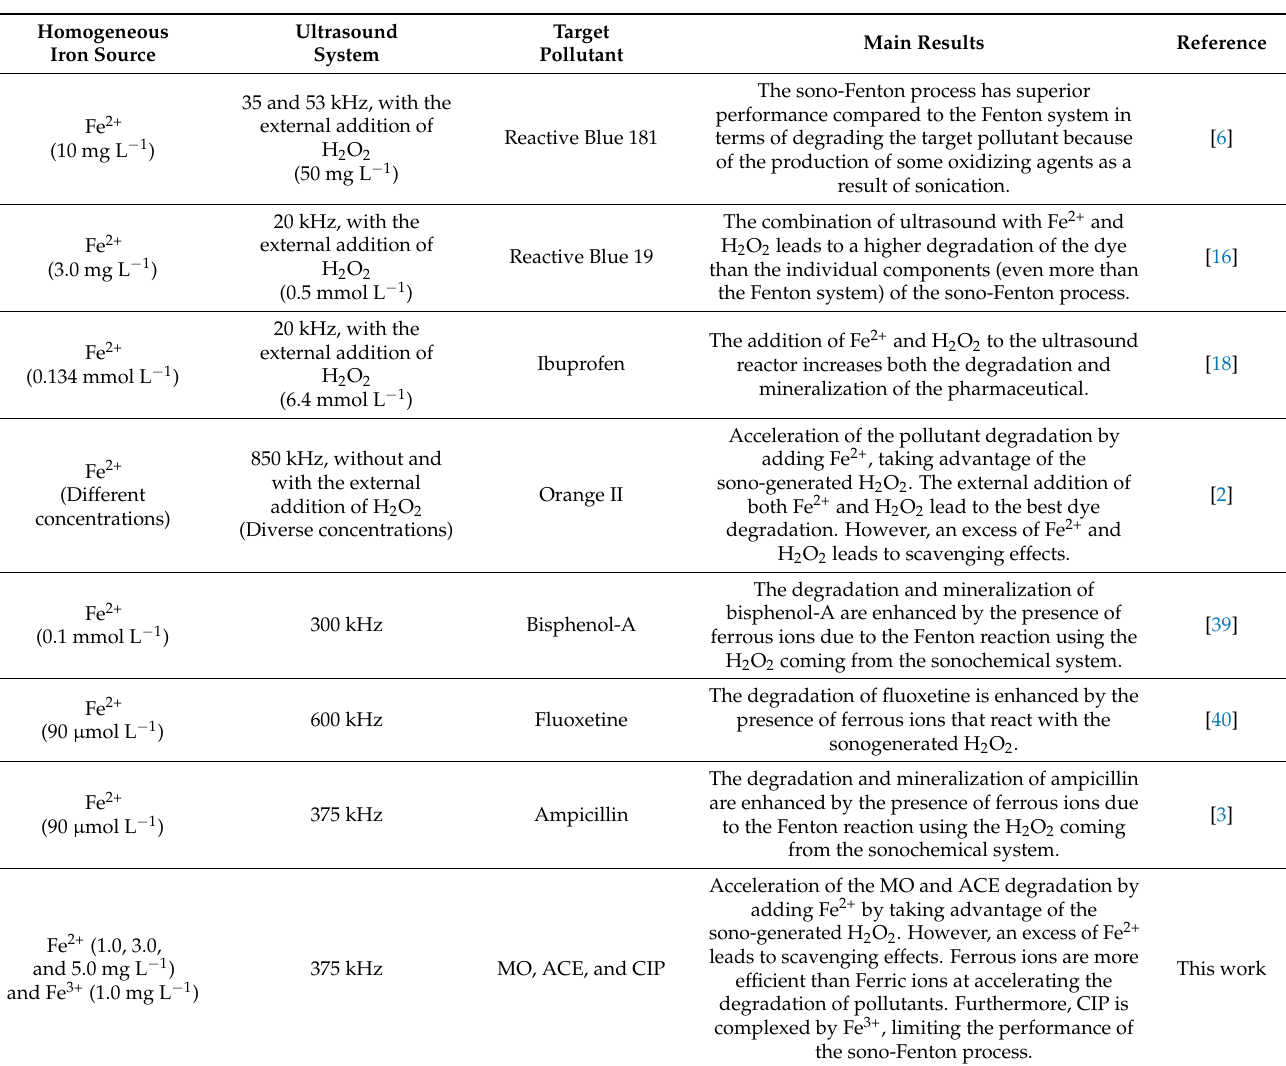
Table 2. Comparison of the tested homogeneous sono-Fenton system with other cases reported in the